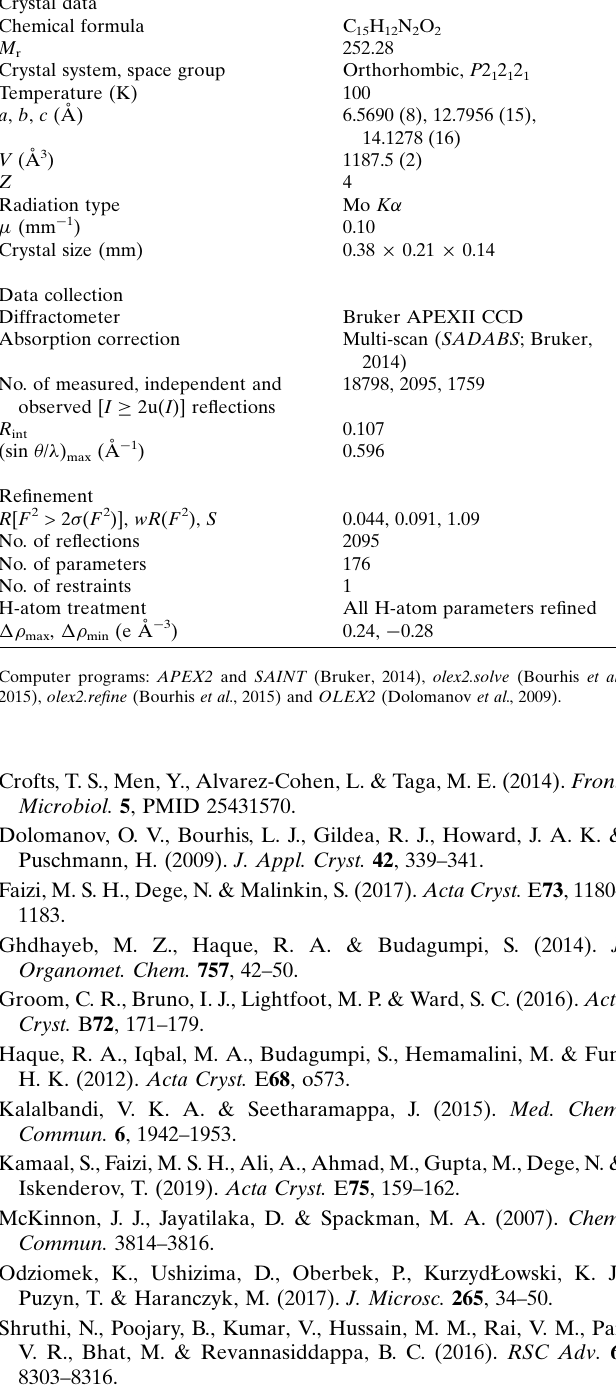
Crystal data Chemical